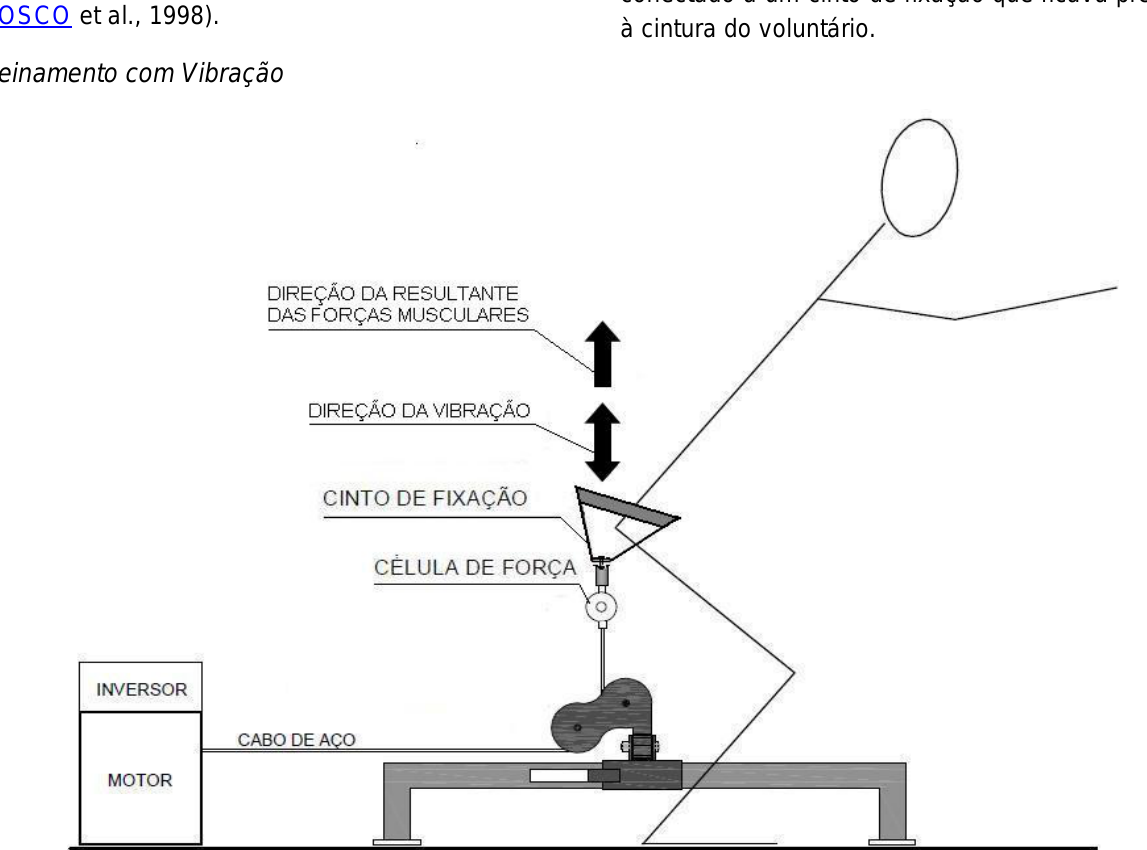
Figura 2. Equipamento para aplicação de vibração